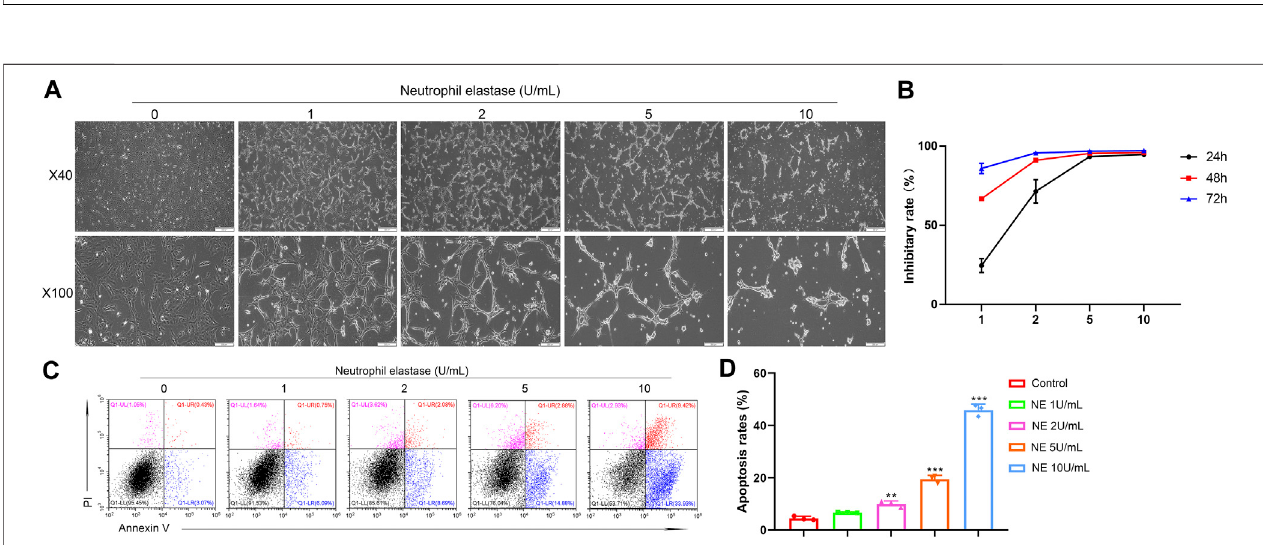
FIGURE 2 | Neutrophil elastase shows potent growth inhibition in chondrocytes in vitro. (A) Representative images of chondrocytes treated with NE for 48 h. The representative fi elds were photographed at × 40 and × 100 magni fi cation. (B) Inhibitory rate histogram of chondrocytes treated with NE for 24 h, 48 h, and 72 h. (C) The fl uorescence pattern of annexin V-FITC/PI staining chondrocytes . (D) Percentages of annexin V positive cells for chondrocytes treated with different doses of NE. Data are mean ± SEM; n (cid:1) 3. ** p < 0.01, *** p < 0.001.